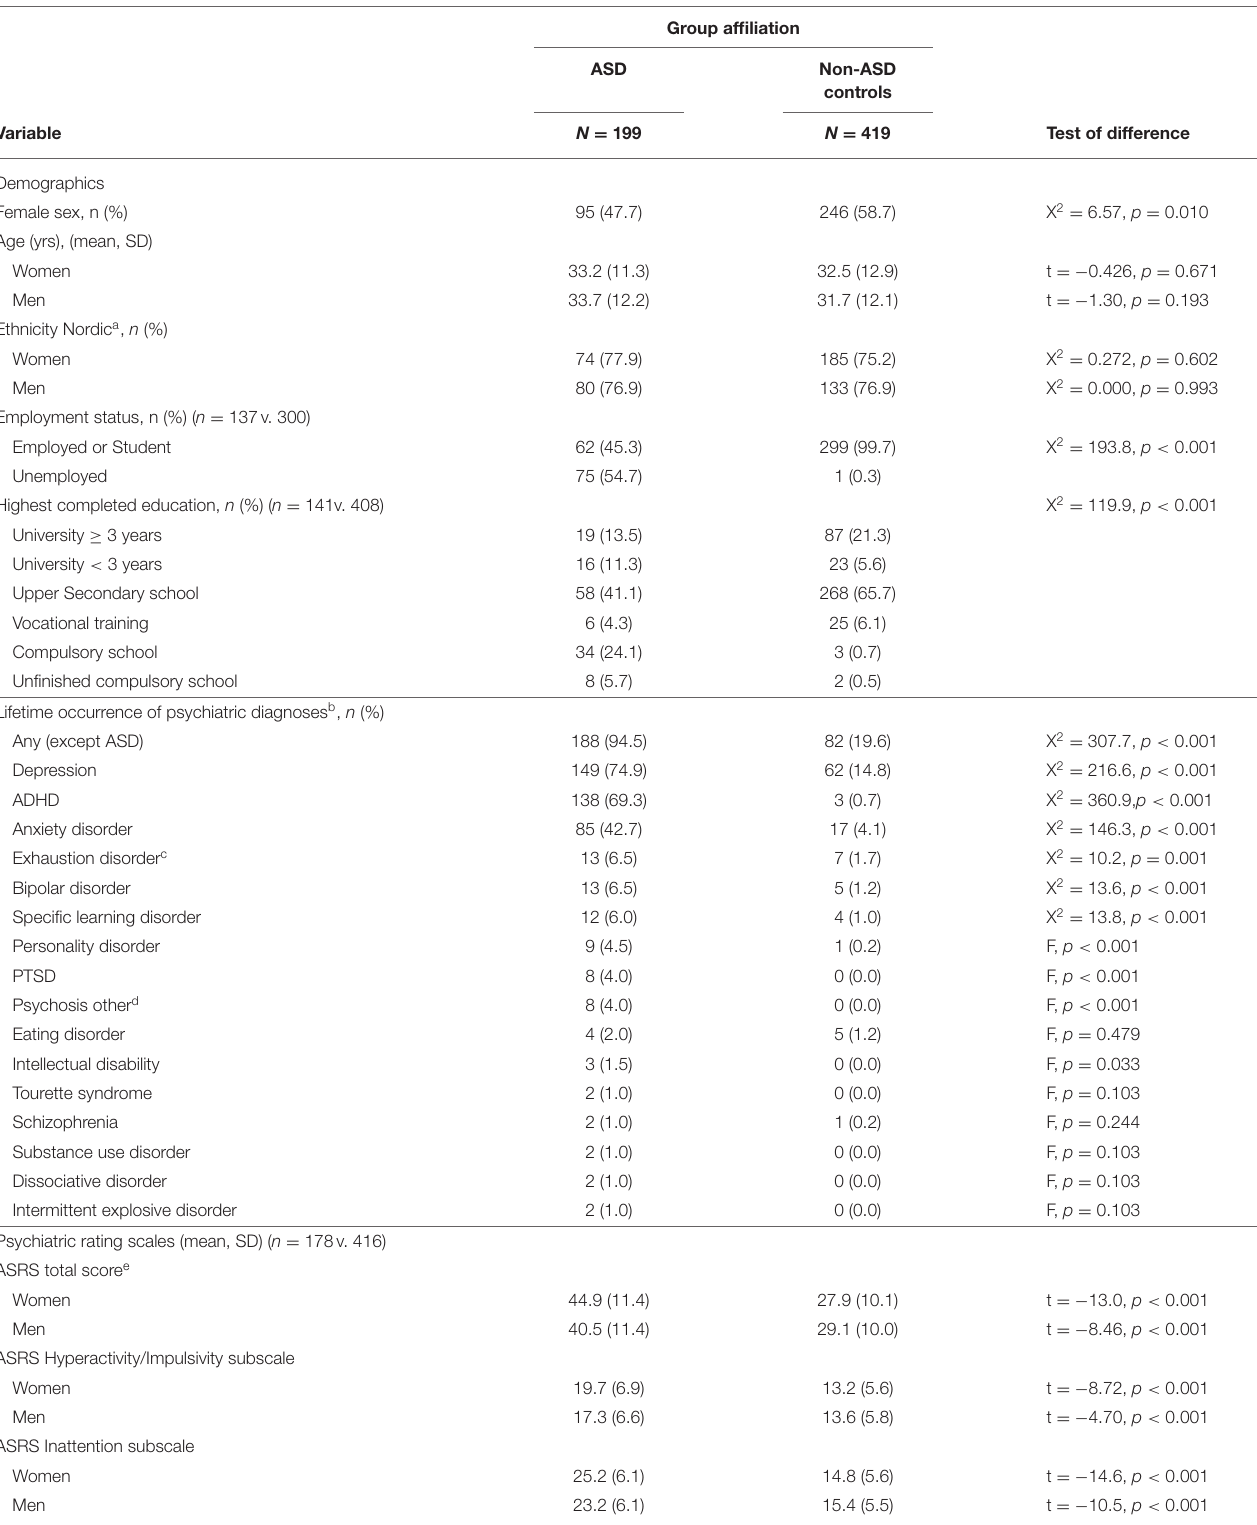
TABLE 1 | Characteristics of the study